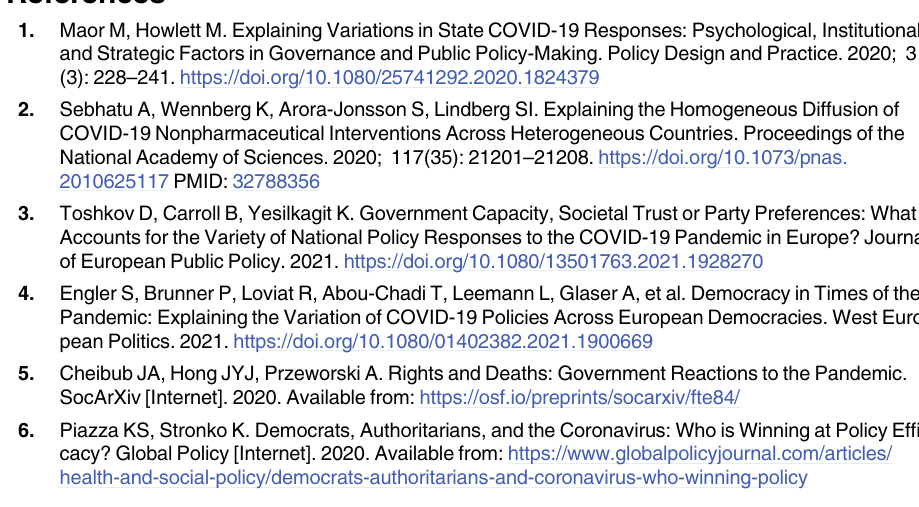
S1 Table. List of countries and the percentage of the population that considers freedom more important than security. S2 Table. Indicators of the Stringency Index. S3 Table. Pairwise correlations. S4 Table. Random effects models for the Stringency Index with interaction term between regime type and freedom vs. security, all countries (n =